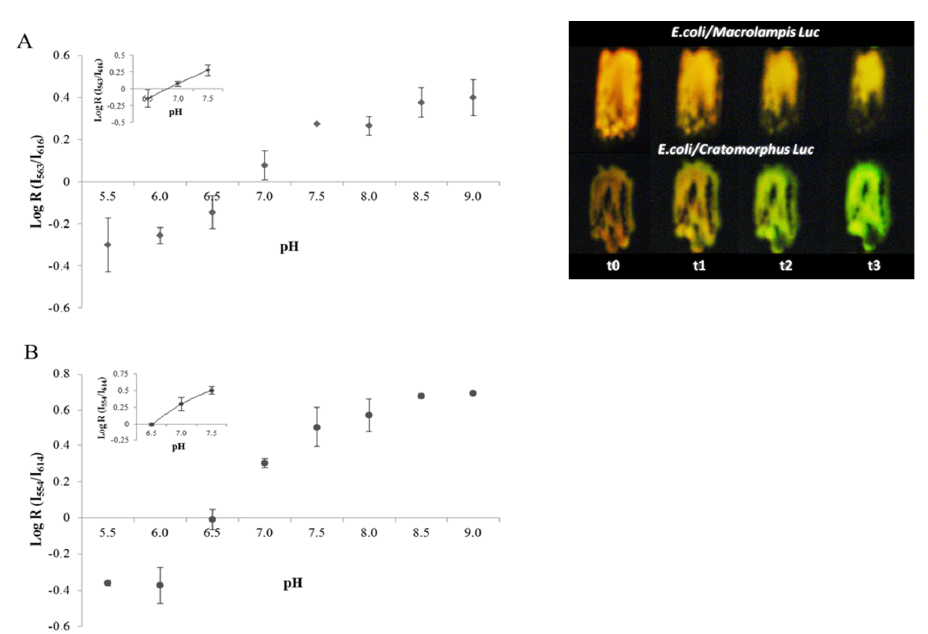
Figure 6. ( Left graph ) ratiometric analysis of pH in bacteria using: ( A ) Macrolampis and ( B ) Crato- morphus firefly luciferases; ( right image ) effect of pH on in vivo bioluminescence of E. coli colonies expressing Macrolampis and Cratomorphus firefly luciferases; (t 0 -t 3 ) represent the time (minutes) when the bioluminescence image was taken after addition of acidic D-luciferin. Reprinted with permission from ref. [32]. Copyright 2014 Royal Society of Chemistry.